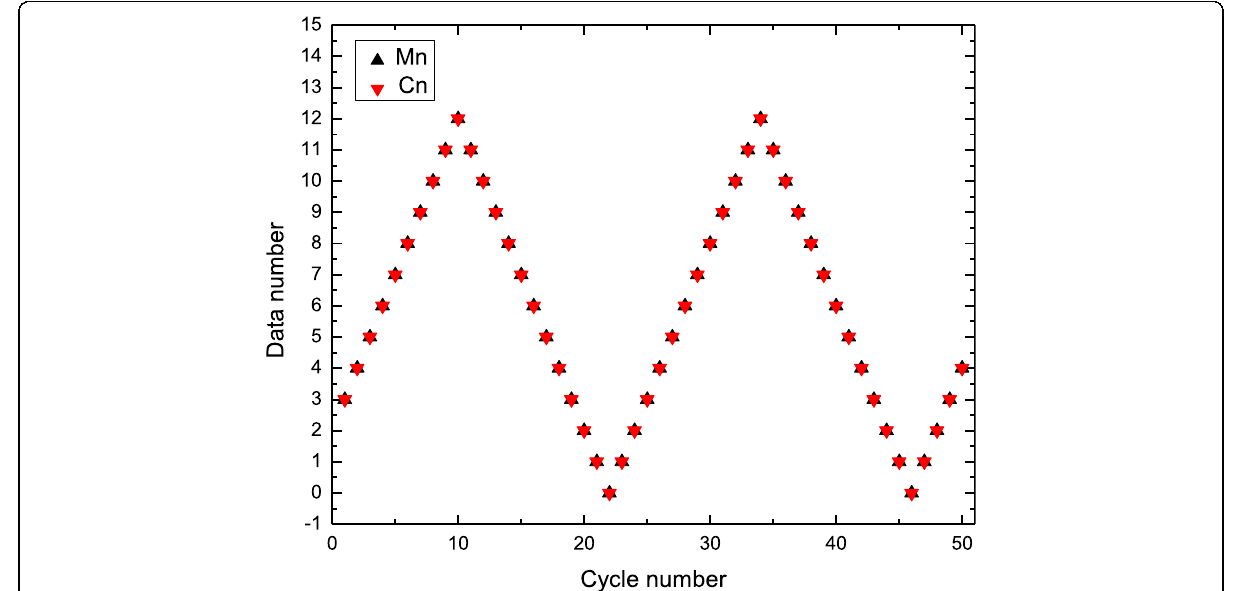
Fig. 16 The total number of periodic data changes increases from 0 to 12; Mn and Cn in the first 50